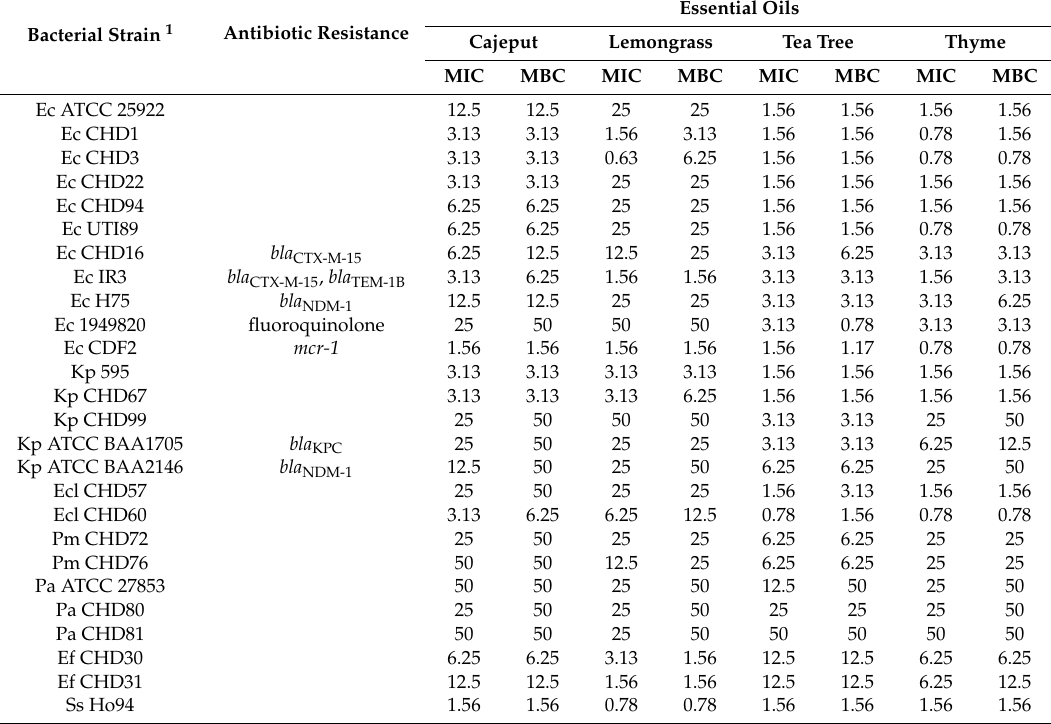
Table 2. Minimum inhibitory and bactericidal concentration (MIC / MBC) [mg / mL] of cajeput, lemongrass, tea tree, and thyme essential oils against 27 uropathogenic strains in artificial urine, determined by broth microdilution assay. Median values from three independent measurements are